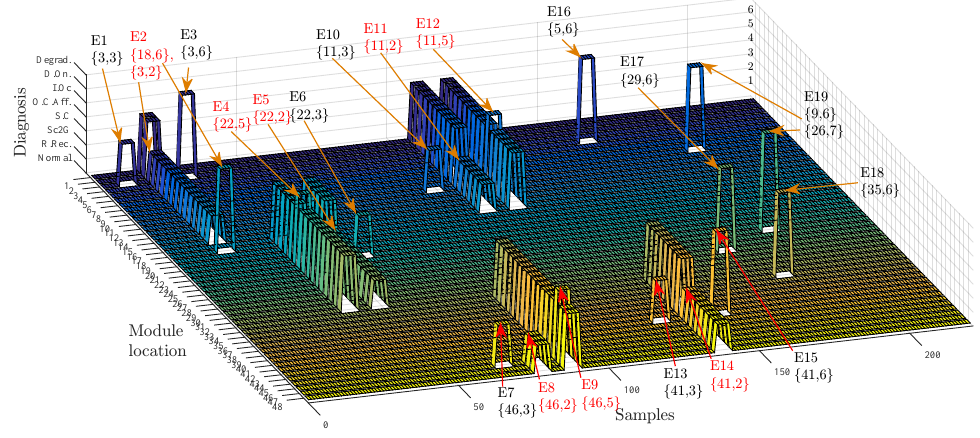
Figure 8. Plotted results of the diagnosis